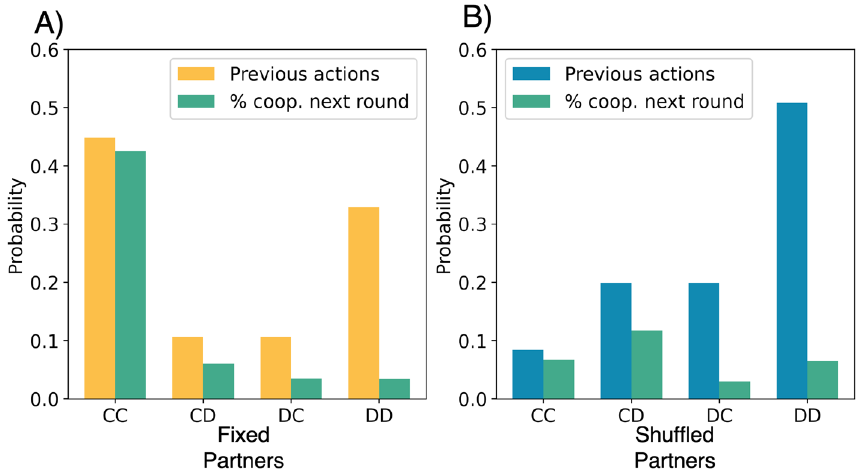
Figure 2. Probability of each context and the cooperation rate per treatment. In the x-axis, the context of each decision is shown, i.e. the actions of the previous round. The green bar in each chart shows the fraction of subsequent cooperative actions when experiencing the particular